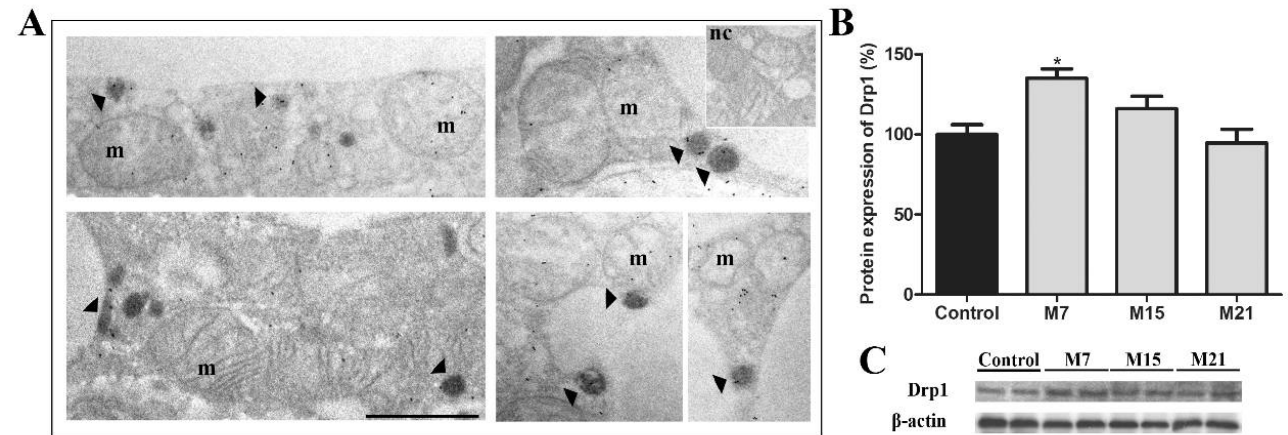
Figure 3. Immunogold labelling of Drp1 on representative images from the hypothyroid group treated with methimazole for 7 days (M7) ( A ) showing that the immunopositive reaction was localized on the mitochondrial outer membrane, on mitochondrial cristae, and some peroxisomes (arrowheads). m, mitochondria; dark peroxisomes labelled by DAB. Inset nc, negative control of immunolabeling. Original magnification 17,000 × , scale bar 1 µ m. ( B ) Protein expression of Drp1 in rat brown adipose tissue of the euthyroid control (black) and hypothyroid groups (grey) treated with methimazole for 7 (M7), 15 (M15), and 21 (M21) days, respectively. The protein content is expressed as a percentage of the control. Band images from a representative blot of three trials are shown ( C ). Bars represent the mean ± SEM. * Compared to control, * p < 0.05.